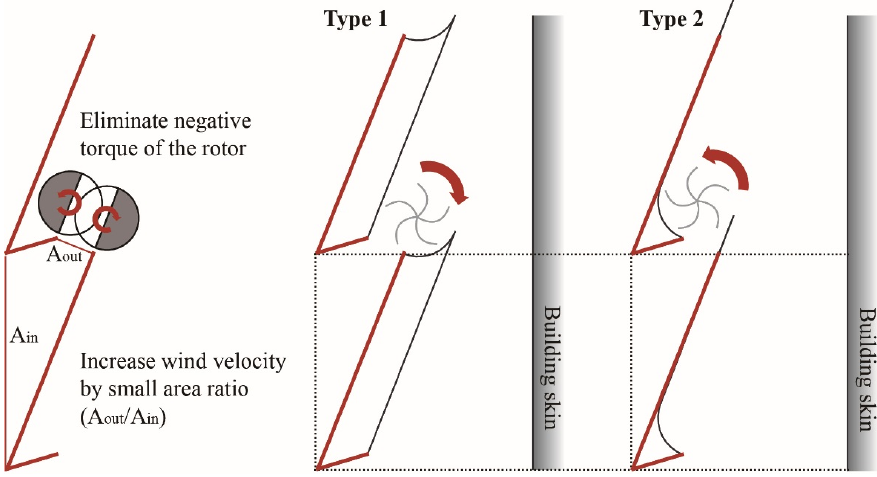
Figure 5. Design issues for the shape of the guide